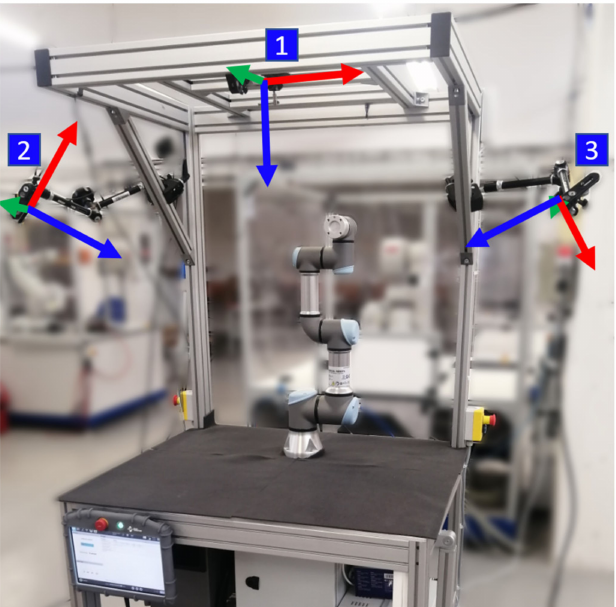
Figure 8. Experimental workspace with depicted locations of three RGB-D sensors (1–3). View directions (Z-axes) are depicted by the blue